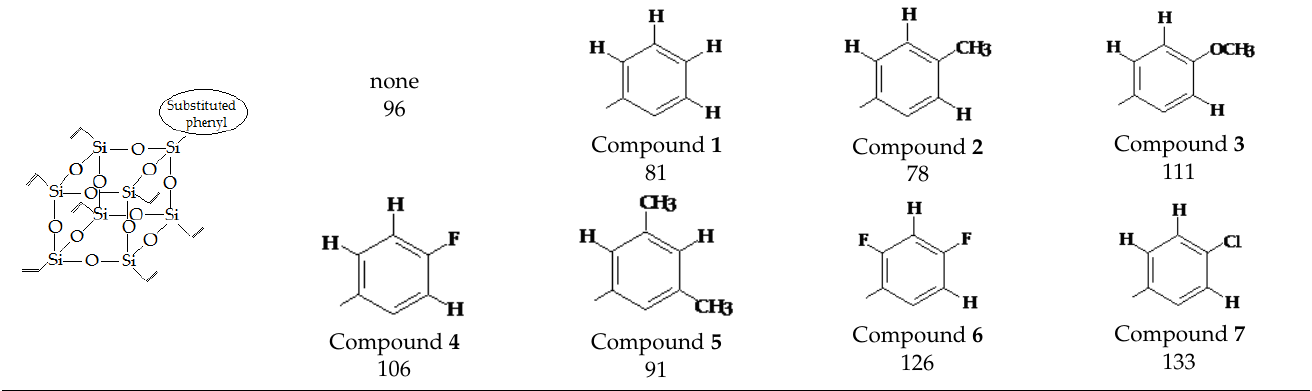
The inclusion of a certain composition of mixed oxides, such as Pb(Zr 0.65-x Ce x Ti 0.35 ), where x takes the three values: 0.075, 0.1 and 0.125 mol in polymer composites with high radiation stabilities, is explicitly proved by means of nonisothermal chemiluminescence measurements [132] (Figure 7). This efficient effect on radiation stabilization is an optimal solution for the improvement in polymers’ durability when they operate in hazardous conditions such as space inspection or maintenance of the in-core NPP zone. The decomposition enthalpy decreases sharply as the concentration of cesium from filler molecules grows significantly. This behavior is explained by the scavenging action of lattice defects that attract, in their gap, the free radicals formed during γ -irradiation of EPDM.